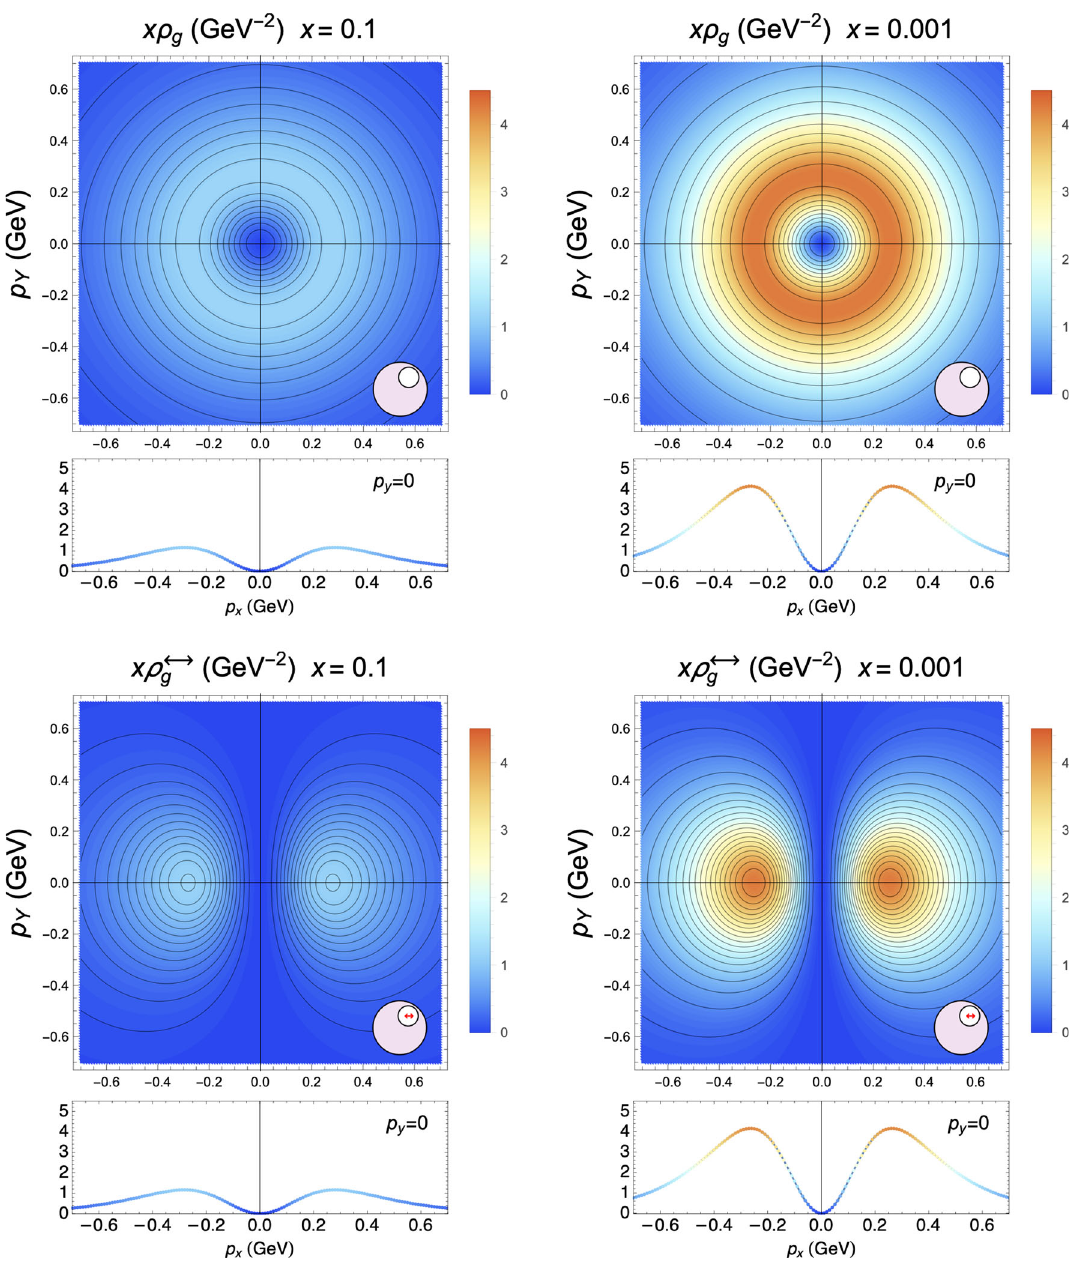
Fig. 5 From top to bottom, the gluon densities of Eqs. (19) and (20) as functions of p T at Q 0 = 1 . 64 GeV and at x = 0 . 1 (left panels) and x = 0 . 001 (right panels) for an unpolarized nucleon virtually moving